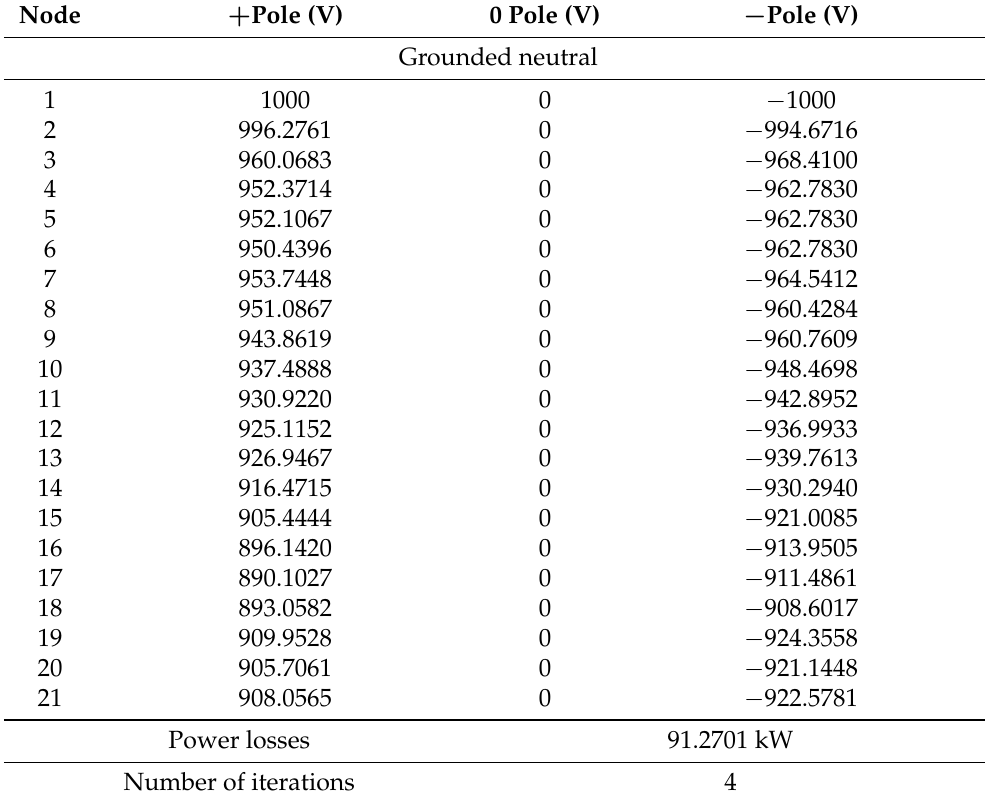
Table 6. Voltages for both simulation cases in the 21-bus